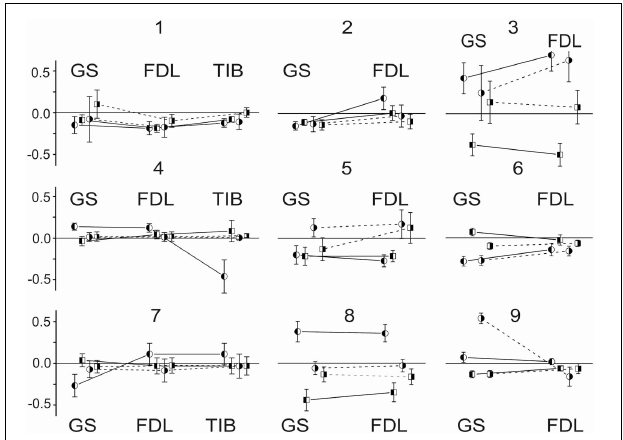
FIGURE 3 | Comparison of relative changes in statistical parameters in FPs recorded at different sides of spinal cord after dynorphin B and naloxone injections. The relative changes (m Dyn / m Con -1) ± (SD Dyn + SD Con )/ m Con ; ( m Nal – m Dyn )/ m Con ± (SD Nal + SD Con )/ m Con are presented at Y axes of the graphs. The variances from a procedure of subtraction between the two stochastic values are summed. The enumeration of experiments is the same as that used in Figure 2 and in Tables 1 , 2 . The circles and squares signify the parameters relating to the dynorphin B and naloxone injections, respectively; the left- and right-hand shadowed symbols are related to the records on the left and right sides of spinal cord. Identical parameters are connected by lines in each experiment, the solid and dashed lines correspond to the left and right sides.